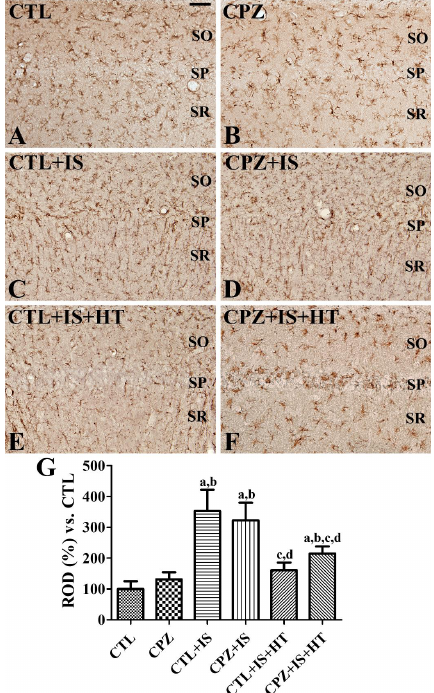
Figure 4. Ionized calcium-binding adapter molecule 1 (Iba-1) immunohistochemistry in the gerbil hippocampal CA1 region of the CTL ( A ), CPZ ( B ), CTL + IS ( C ), CPZ + IS ( D ), CTL + IS + HT ( E ), and CPZ + IS + HT ( F ) groups. Iba-1-immunoreactive microglia were mainly observed in the stratum oriens (SO) and stratum radiatum (SR). Iba-1-immunoreactive microglia have a rounded form cytoplasm in the stratum pyramidale (SP) in the CTL + IS, CPZ + IS, and CPZ + IS + HT groups. Scale bar = 50 μM. ( G ) RODs were expressed as a percentage of the Iba-1 immunoreactivity detected compared to the CTL group in the hippocampal CA1 region for each section ( n = 5 per group, a p < 0.05, significantly different from the CTL group; b p < 0.05, significantly different from the CPZ group; c p < 0.05, significantly different from the CTL + IS group; d p < 0.05, significantly different from the CPZ + IS group). Error bars indicate standard deviation.